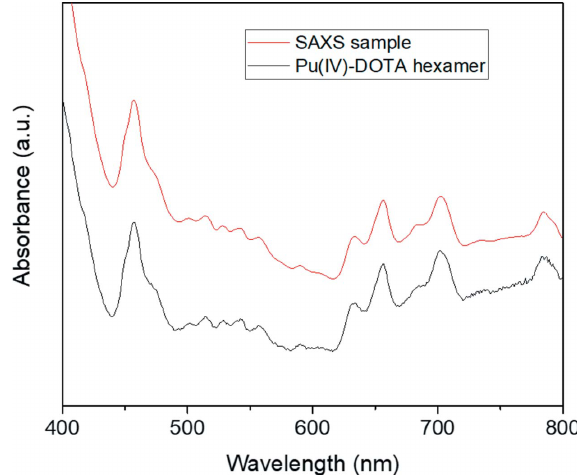
Figure 1 UV–Vis absorption spectrum of the SAXS–XAFS sample compared with the Pu IV –DOTA hexamer identified by single-crystal